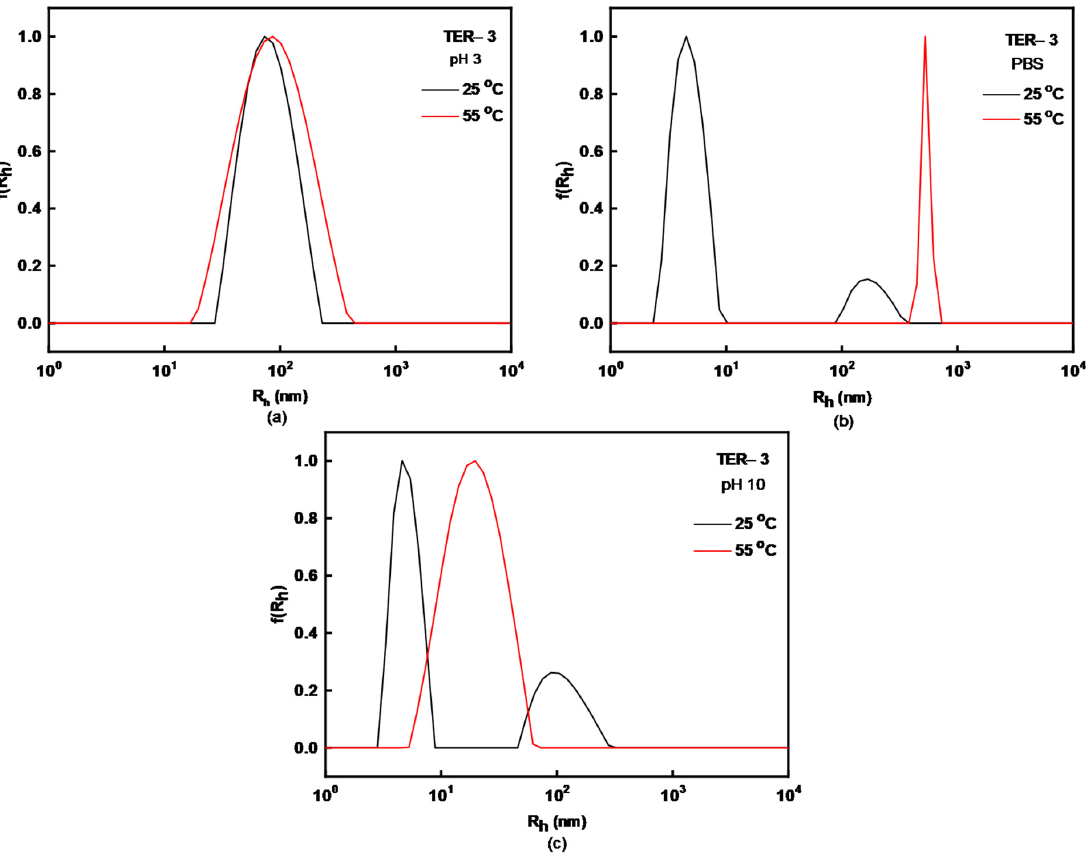
Figure 6. CONTIN size distributions for TER-3 terpolymer at ( a ) pH = 3, ( b ) PBS and ( c ) pH = 10 as a function of temperature.